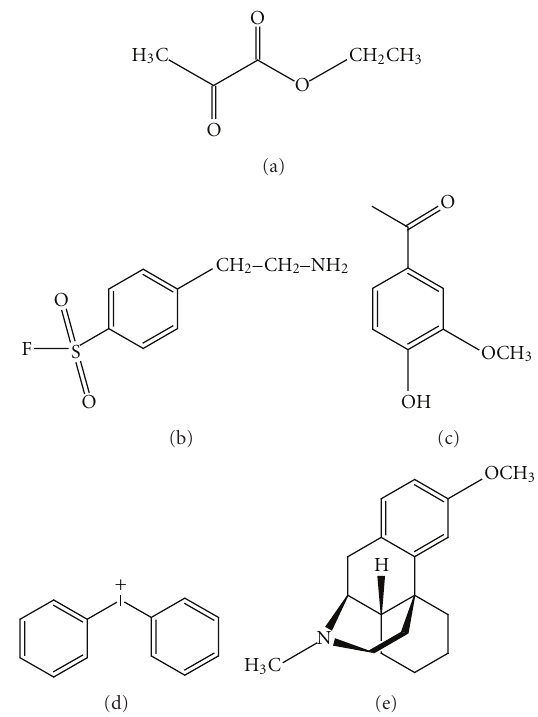
Figure 1: Chemical structure of ethyl pyruvate (a), aminoethyl- benzenesulfonylfluoride (b), apocynin (c), diphenyliodonium (d) and dextromethorphan